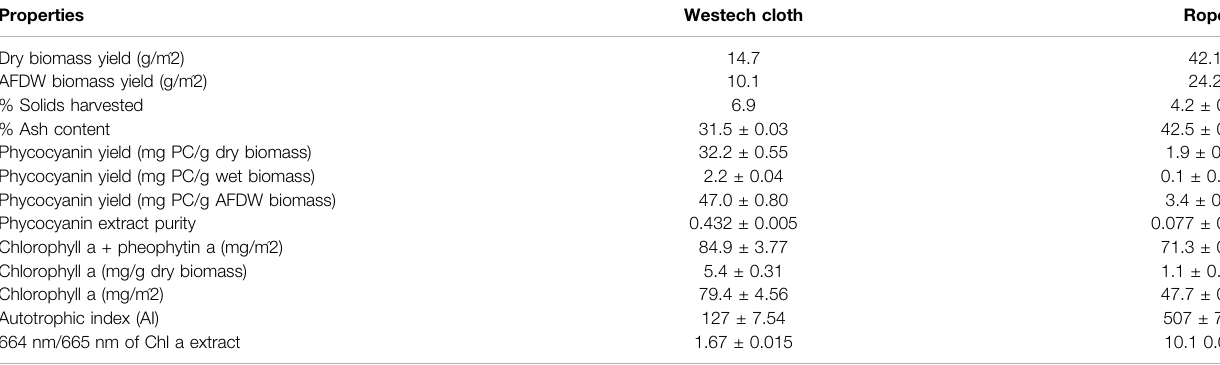
TABLE 2 | Comparison of properties of biomass cultivated on cotton rope versus fl at cotton belt substrata on an outdoor fl oating RABR.